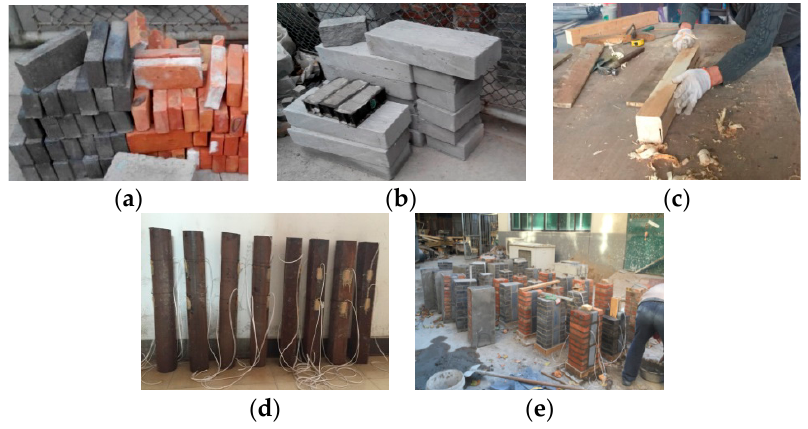
Figure 3. Preparation of materials and specimens: ( a ) recycled concrete bricks and clay bricks; ( b ) fly ash blocks; ( c ) square-shaped wood embedded; ( d ) lightweight concrete-filled steel stem; and ( e ) making of the specimens.